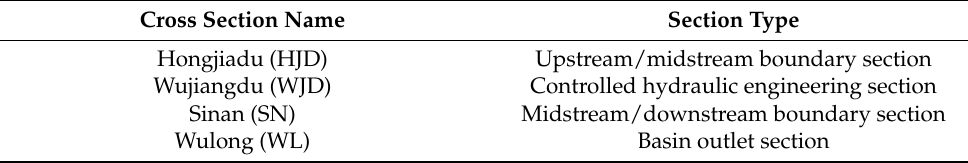
Table 1. Critical sections for ecological protection on the Wujiang